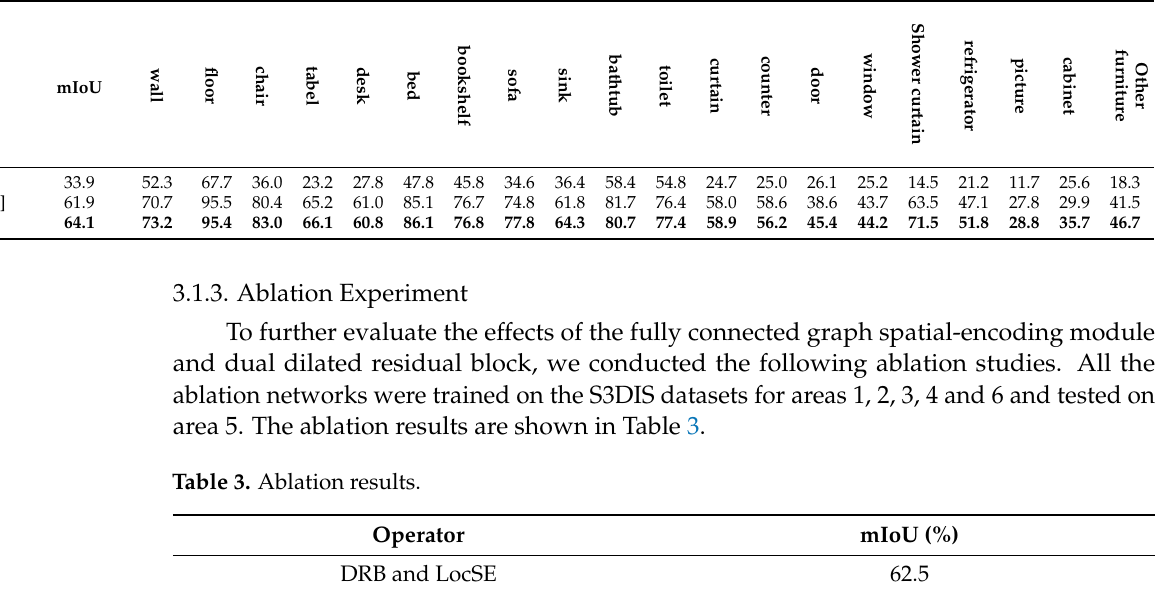
Figure 11. The ScanNet dataset.